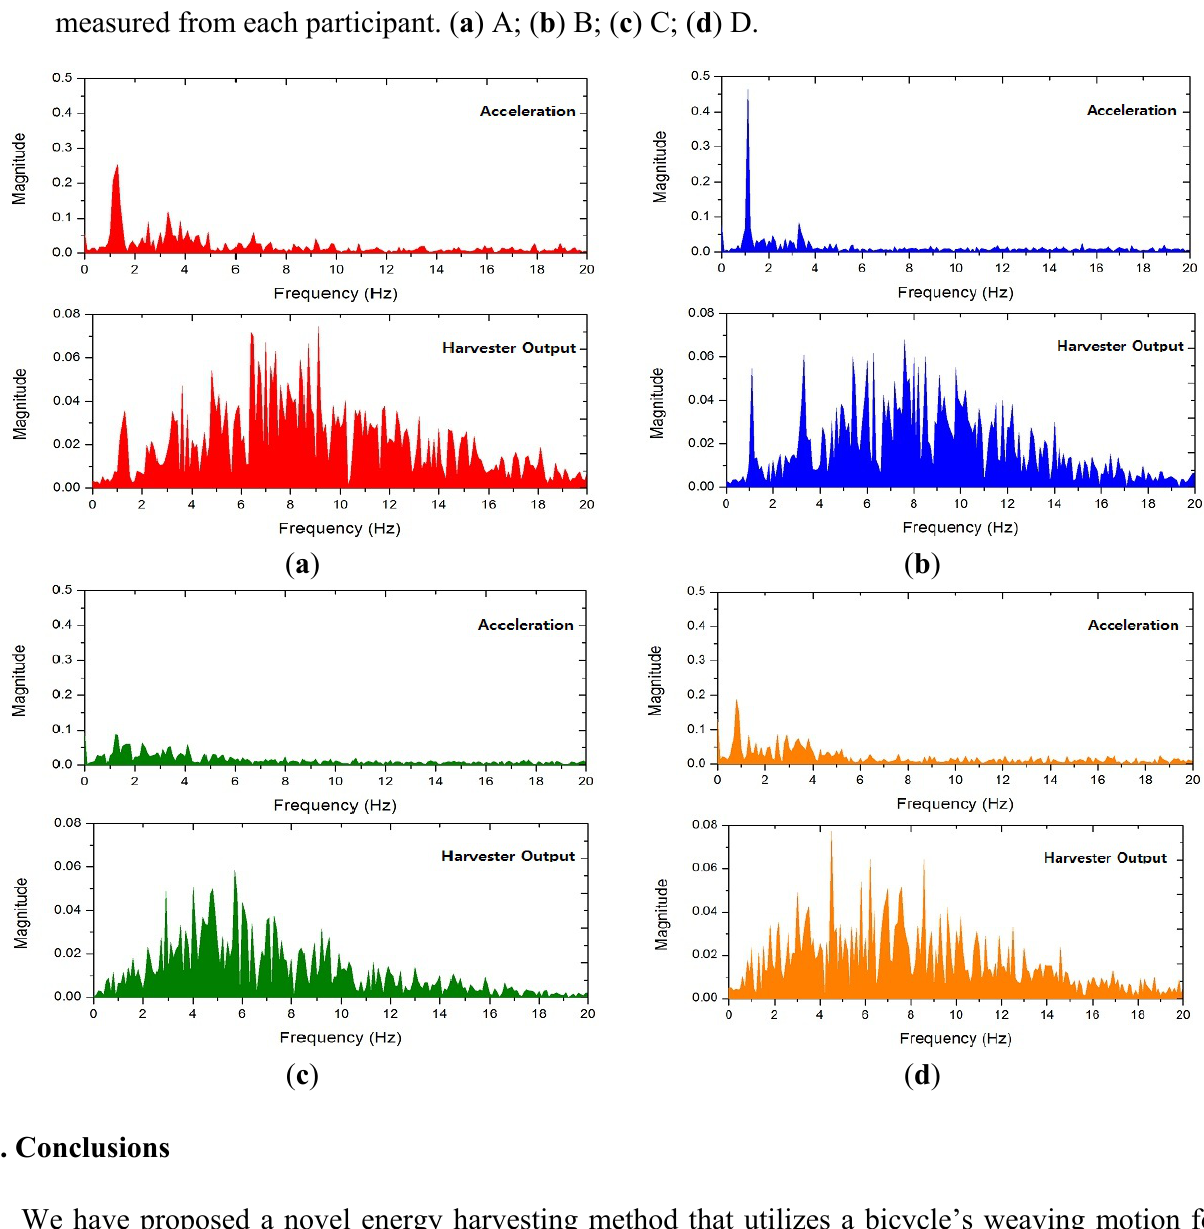
Figure 9. Power spectral density (PSD) estimation of acceleration and harvester